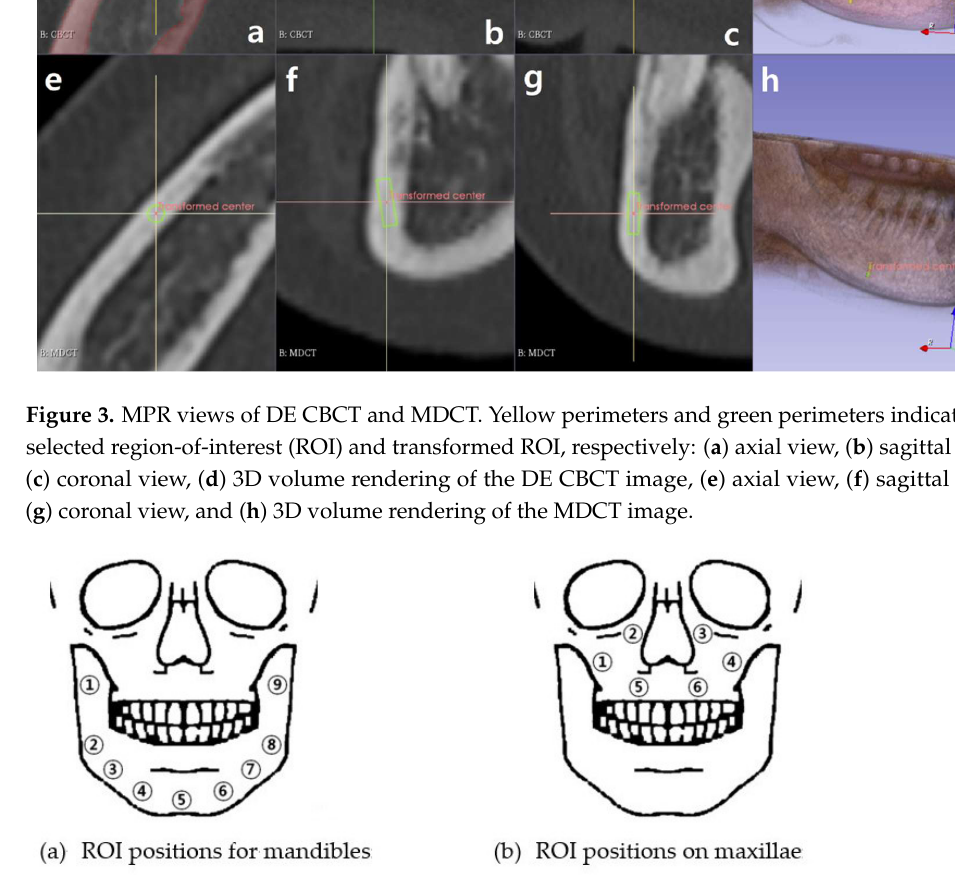
Figure 3. MPR views of DE CBCT and MDCT. Yellow perimeters and green perimeters indicate the selected region-of-interest (ROI) and transformed ROI, respectively: ( a ) axial view, ( b ) sagittal view, ( c ) coronal view, ( d ) 3D volume rendering of the DE CBCT image, ( e ) axial view, ( f ) sagittal view, ( g ) coronal view, and ( h ) 3D volume rendering of the MDCT image .